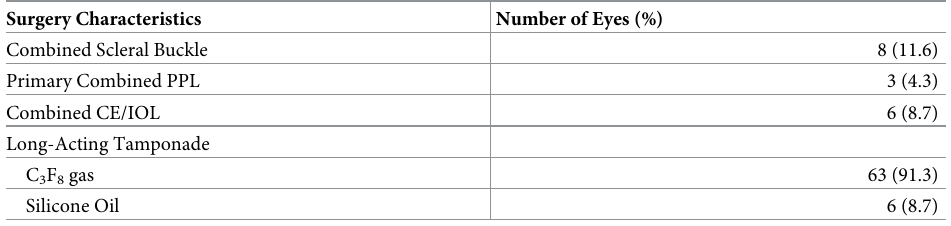
Table 3. Intraoperative procedures (n = 69).